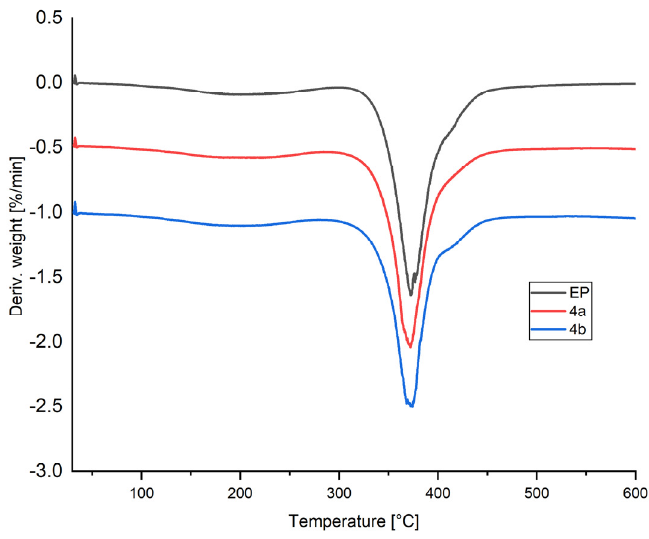
Figure 7. Char residue curve for EP, 4a and 4b .